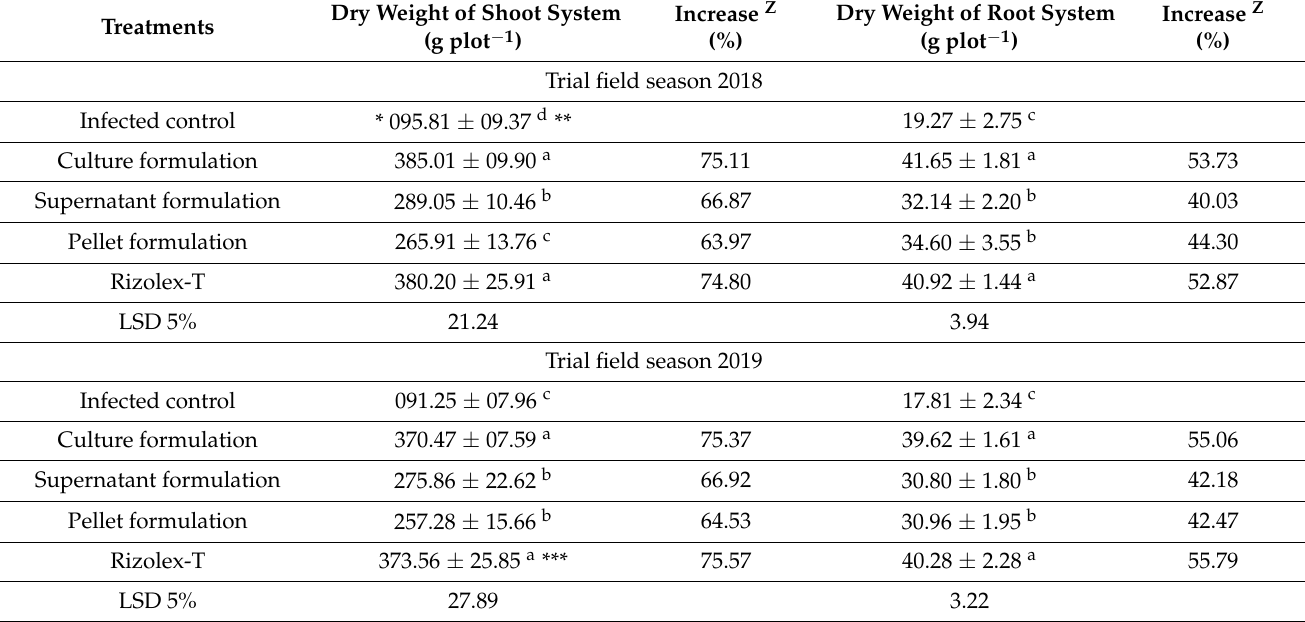
Table 6. Effect of treatment with talc-based formulations of Streptomyces cellulosae Actino 48 on dry weight of shoot and root system of peanut under open-field conditions during seasons of 2018 and